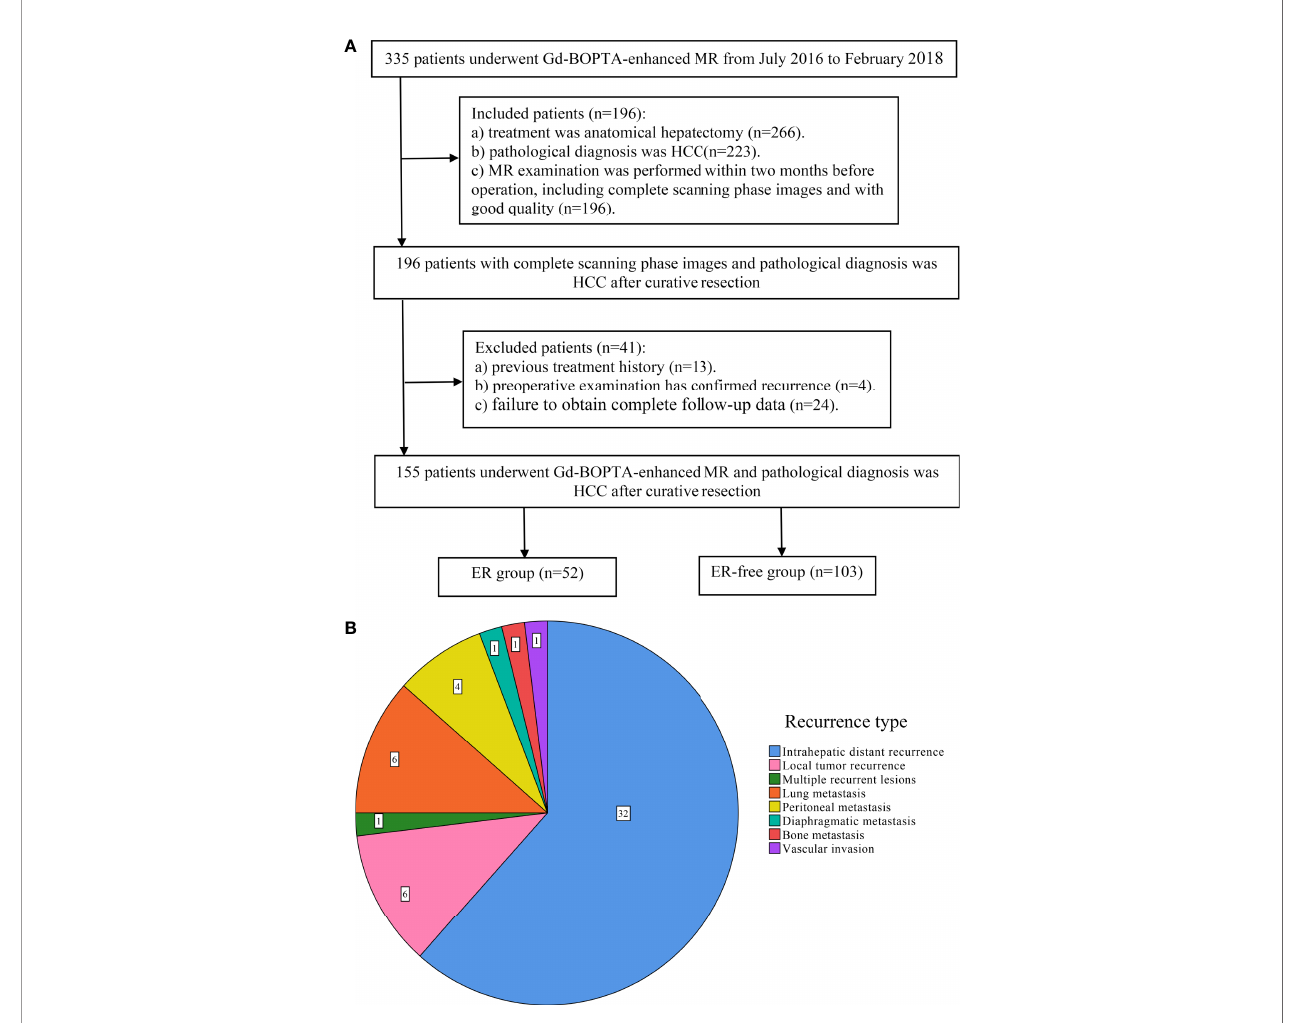
FIGURE 1 | Flowchart of study population and the type of early recurrence. (A) The work fl ow of patient selection for this study; (B) pie chart of early recurrence